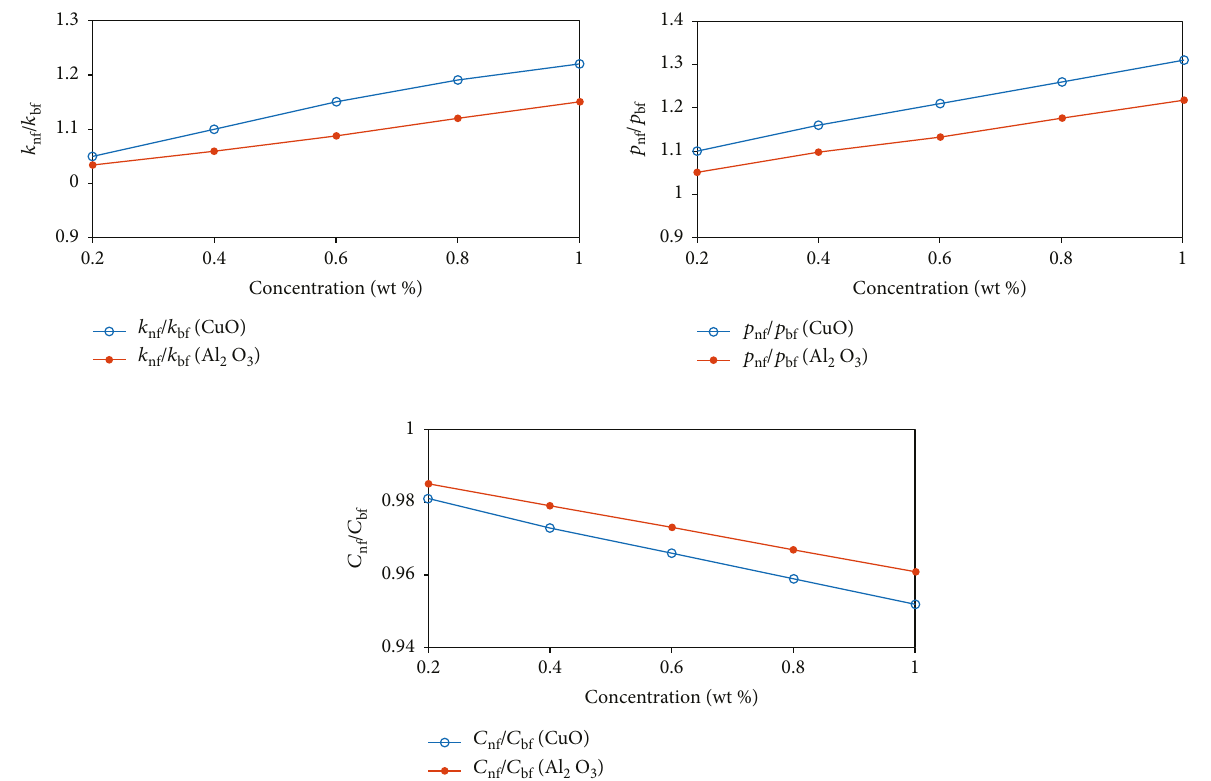
Figure 3: Variations of thermal physical properties of Al